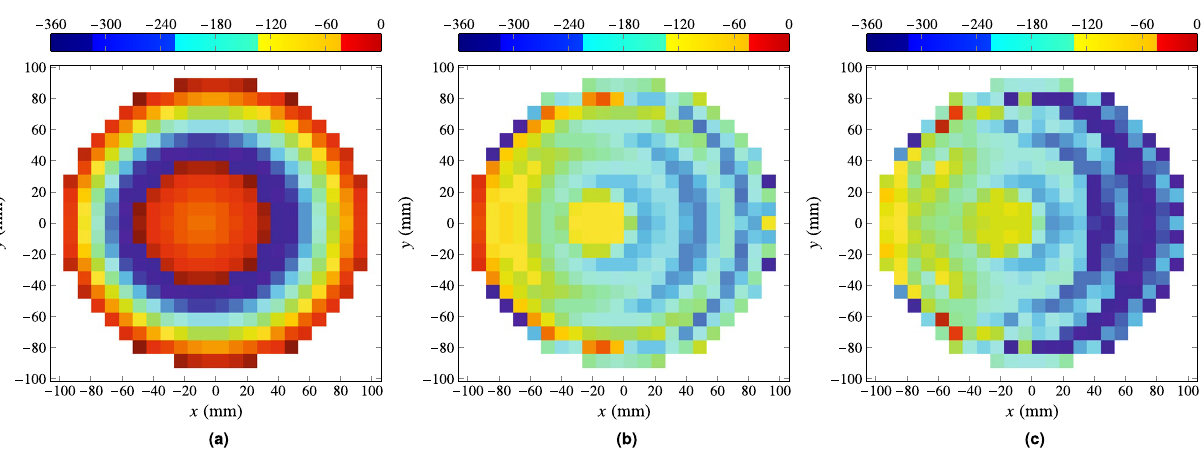
Figure 7. Required phase-shift at each reflectarray element to ( a ) achieve a pencil beam pattern pointing at ( θ 0 , ϕ 0 ) = ( 23 ◦ , 0 ◦ ); ( b ) obtain an isoflux pattern using an ideal far field model for the feed horn based on a cos q θ function with q = 15 ; and ( c ) obtain an isoflux pattern using the spherical wave expansion model for the feed horn. Figure created with PGFPlots 63